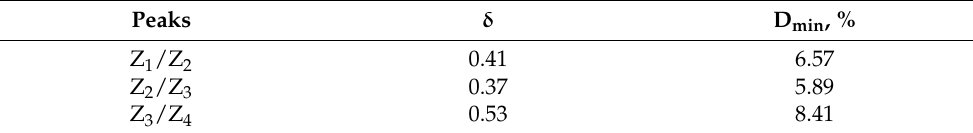
Figure 12. Small-strain FVD of a low-plasticity clay (CL) specimen [7]. Table 3. Logarithmic decrements and viscous damping ratios analyzed by the conventional method of